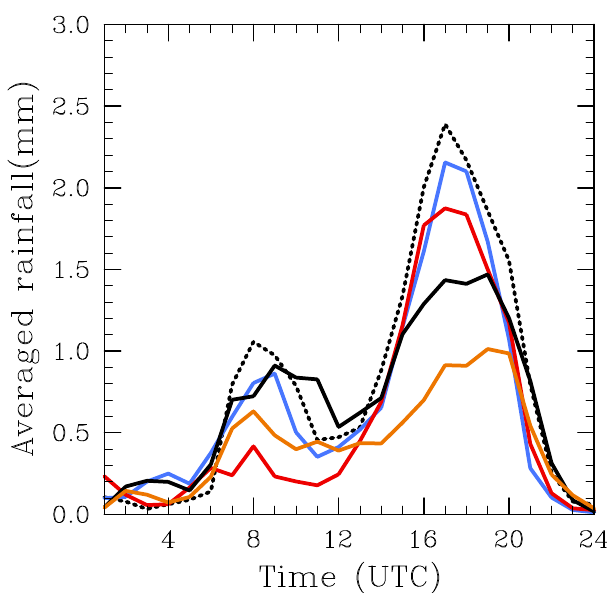
Fig. 10. Temporal evolution of the spatially-averaged hourly accumulation of the rainfall field for each member of the ICBC7a en- semble between 00:00UTC on 26 September and 00:00UTC on 27 September. The AROME member appears in blue, the AROME- WMED member in red, the ECMWF member in black and the ARPEGE member in orange. The black dotted line represents the evolution of the observed rainfall field.